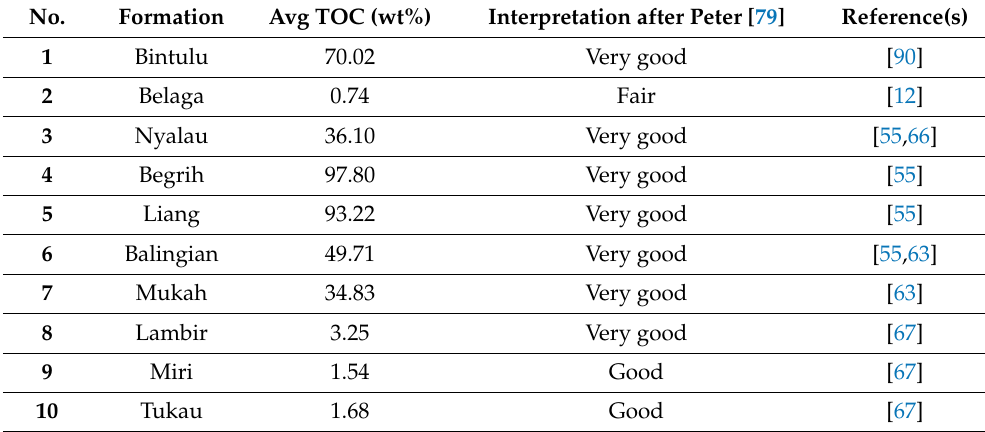
Table 13. Interpretation of average TOC values of formations in Sarawak according to Peter [79].